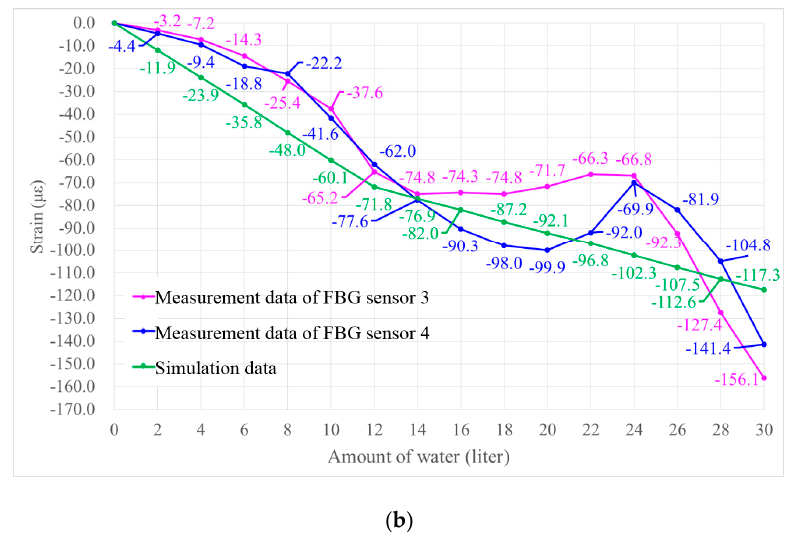
Figure 19. Comparison of measurement data and simulation data under full load condition. ( a ) For sensors 1 and 2; ( b ) For sensors 3 and 4.